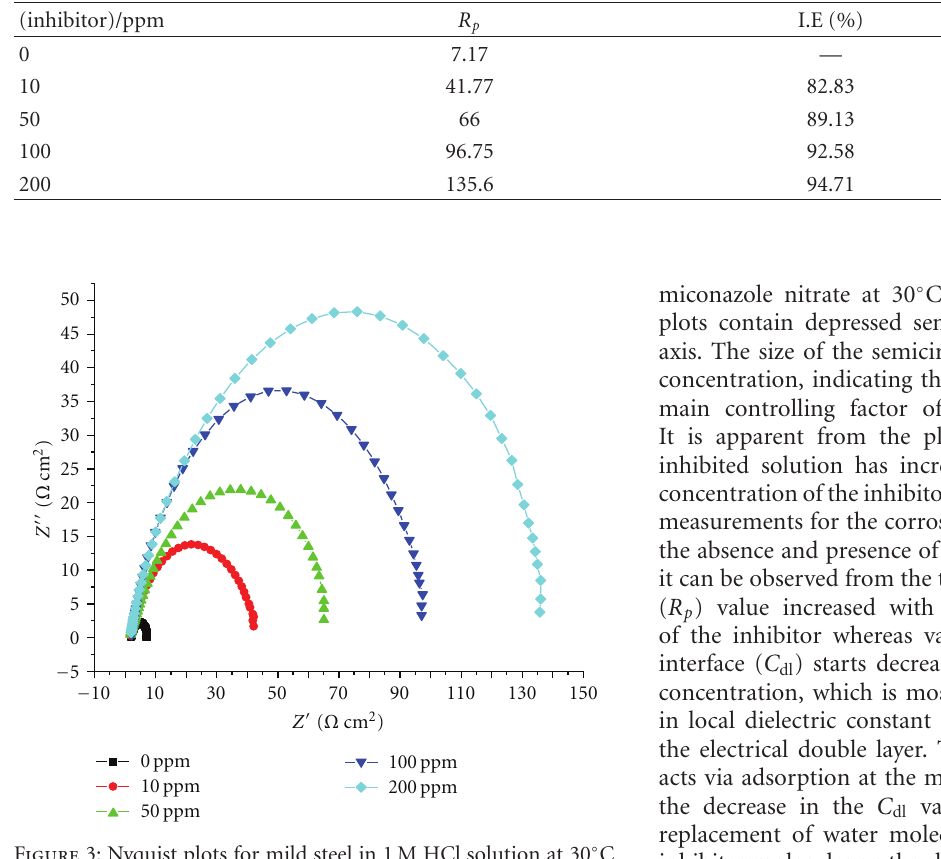
Figure 3: Nyquist plots for mild steel in 1 M HCl solution at 30 ◦ C containing various concentrations of